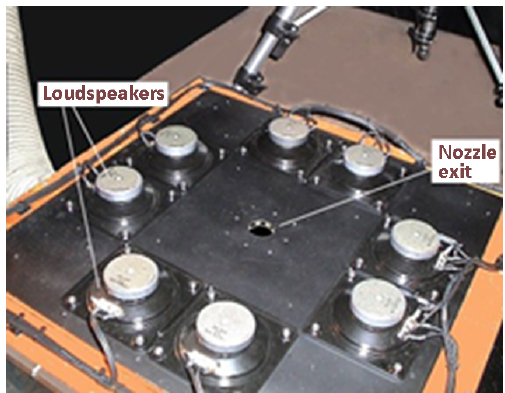
Figure 1. Photographic image of the acoustic excitation chamber with eight loudspeakers that are placed in a flatwise manner to gen- erate the necessary acoustic pressure in order to perturb the jet shear layer at the nozzle exit.